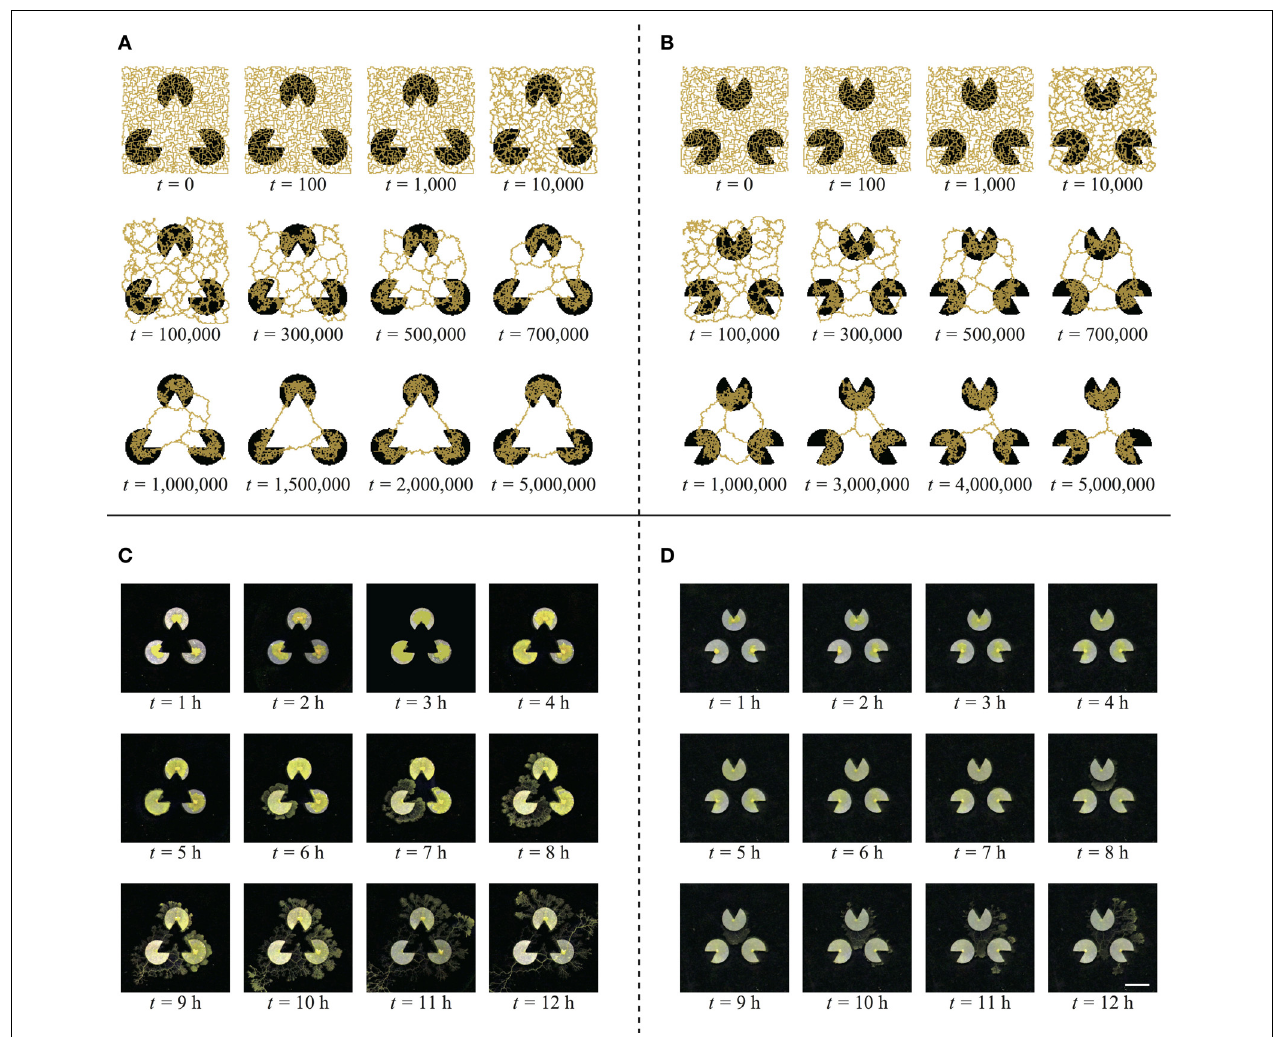
FIGURE 7 | Typical evolution of the networks of model (A,B) and real plasmodium (C,D) (scale bar: 10mm). (A) For the Kanizsa diagram, the network structures are highly stable. (B) In the control diagram, the network